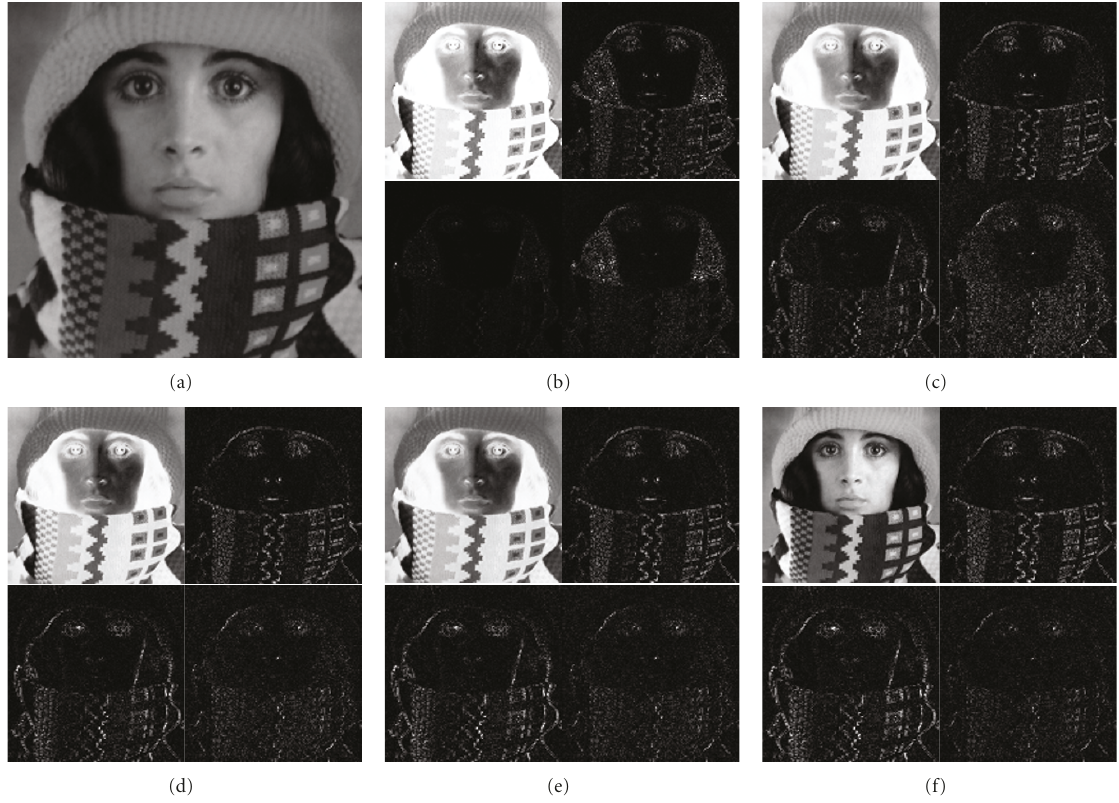
Figure 2: (a) Original “Trui” image, top-left: approximation subband, magnitude of top-right: horizontal subband, bottom-left: vertical subband, bottom-right: diagonal subband magnitude of horizontal subband using the SWT and PLIP model operators with (b) γ = 256 (LIP model case), (c) γ = 300, (d) γ = 500, (e) γ = 700, and (f) standard mathematical